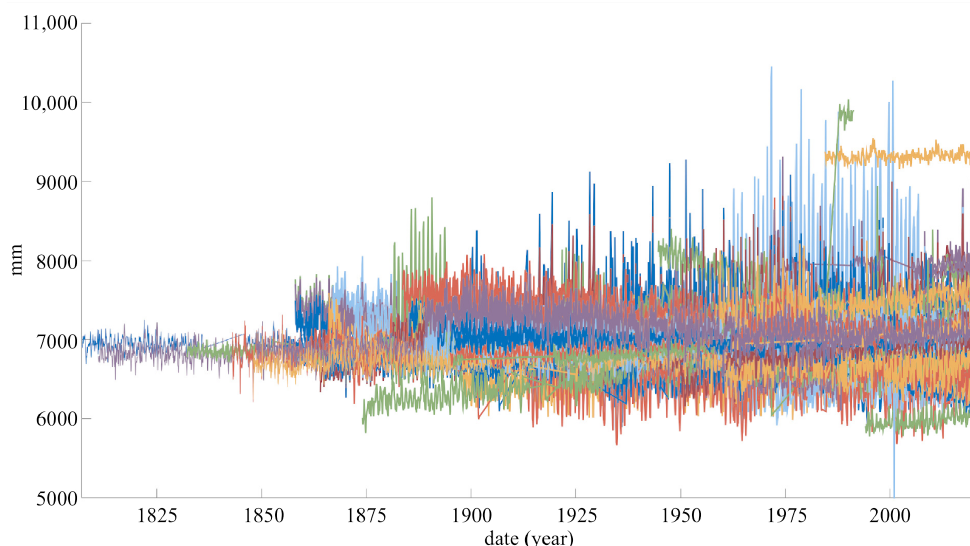
Figure 1. The full tide gauge database (1548 tide gauges of PSMSL